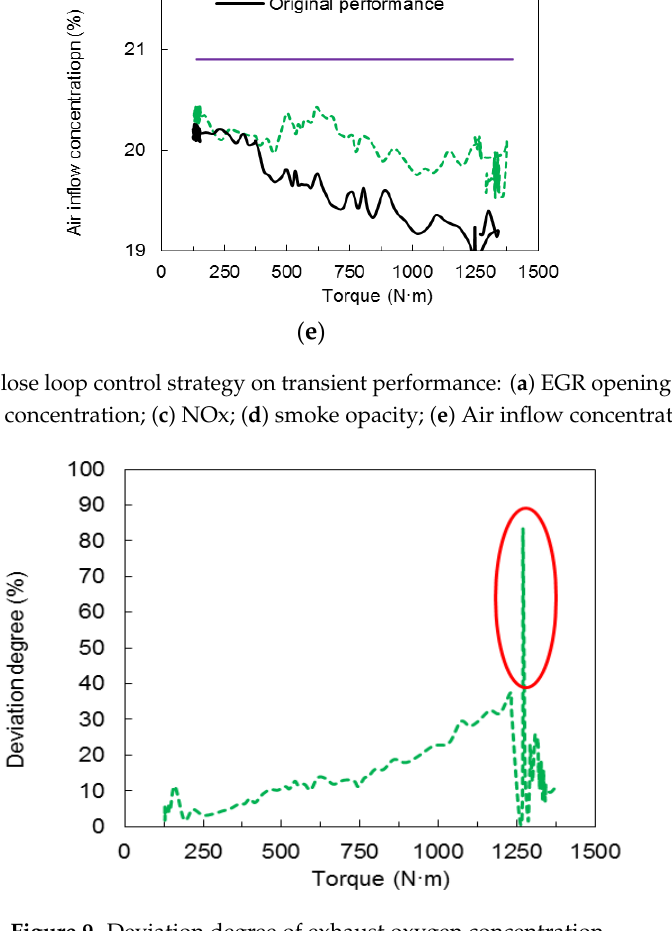
Figure 9. Deviation degree of exhaust oxygen